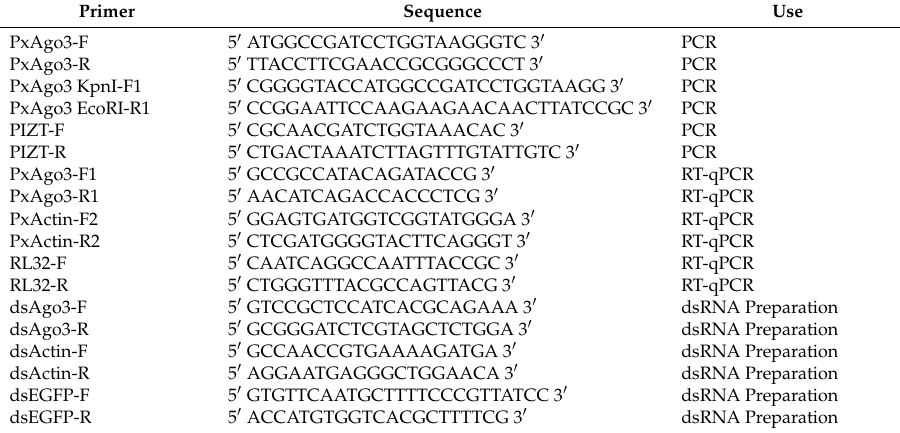
Table 1. Primers used in the three experiments of vector construction, expression and suppression for PxAgo3.